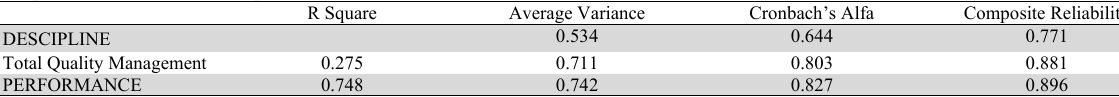
Path Coefficients (Mean, STDEV, T-Values)